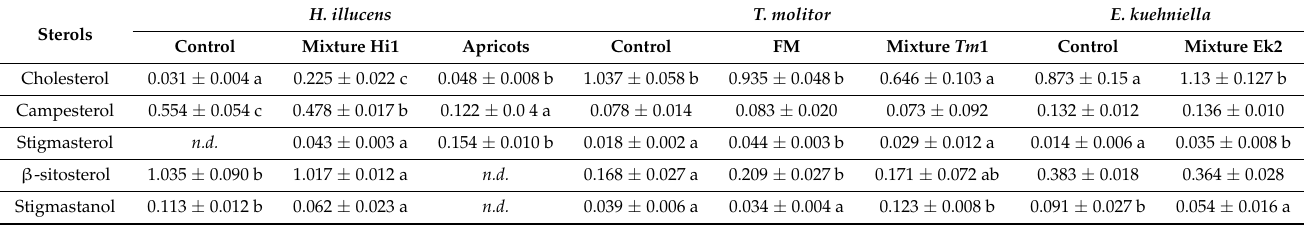
Table 5. Concentration of sterols (g/kg dry matter) in the three larvae species as a function of diet. H. illucens T. Sterols